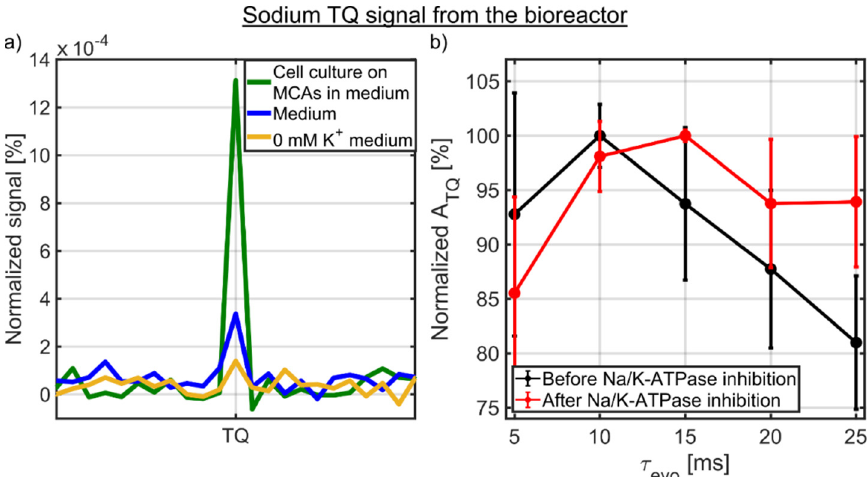
Figure 5. ( a ) Sodium TQ signal of 0 mM K + medium, medium and 3D cell culture on MCAs in medium